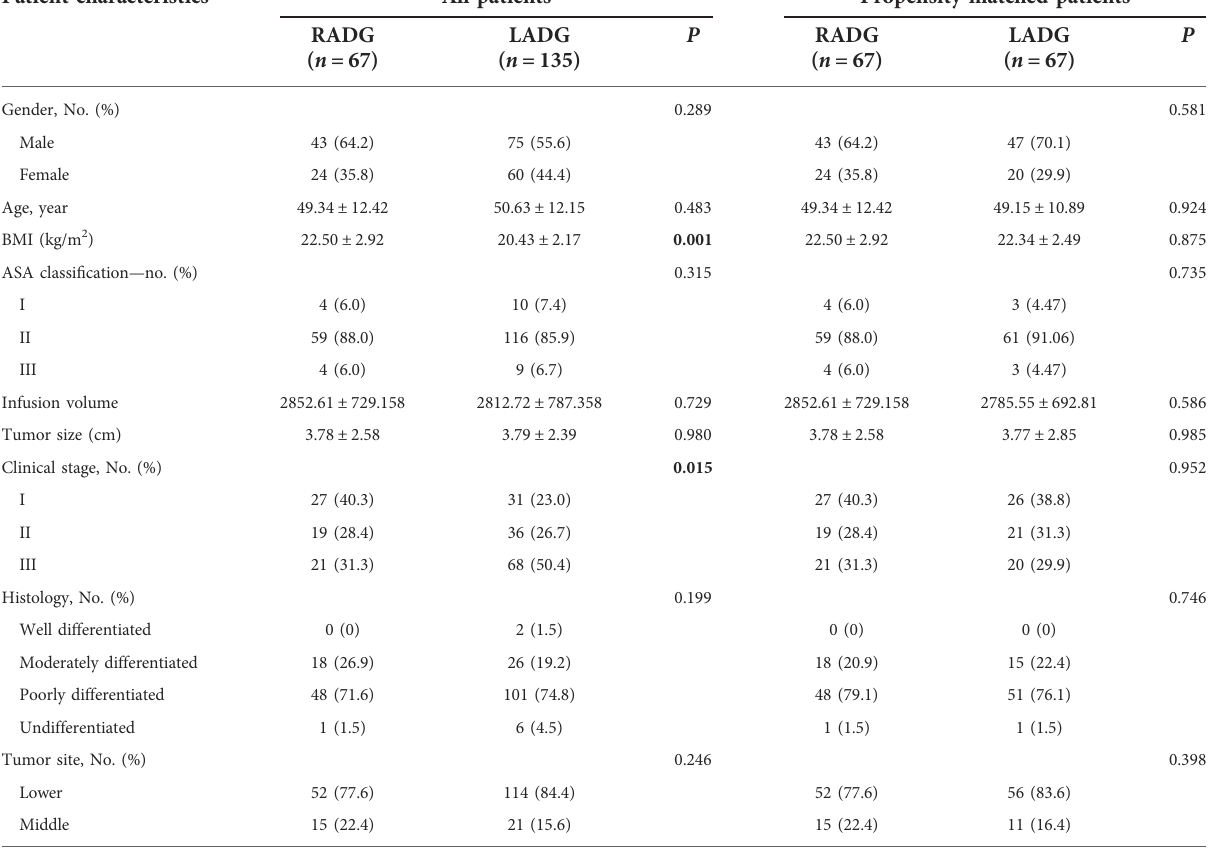
TABLE 2 Baseline characteristics of the RADG and LADG groups, before and after weighing. Patient characteristics